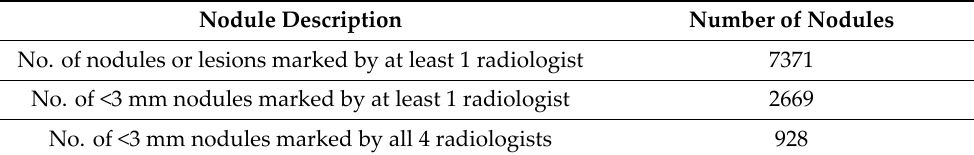
Table 6. LIDC‑IDRI database